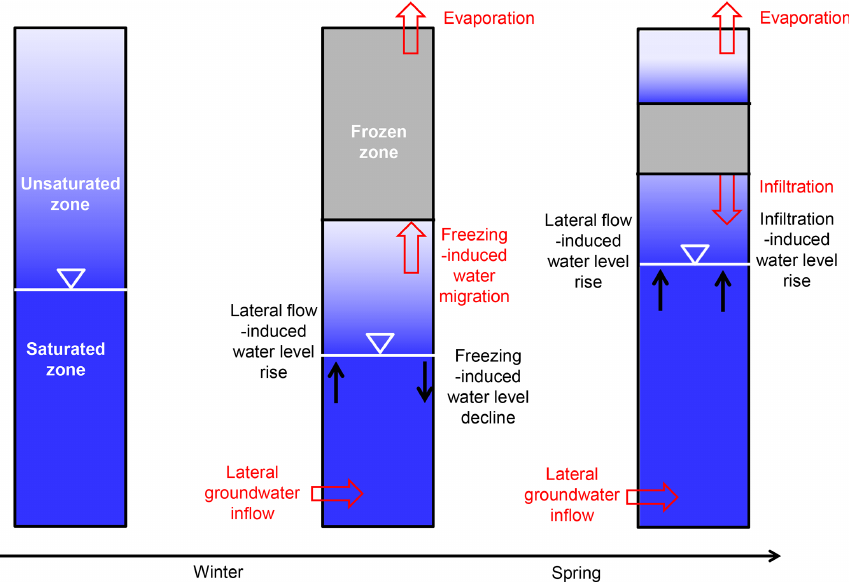
Figure 1. The conceptual model showing main hydrological and hydrogeological processes in semi-arid regions during the freezing–thawing